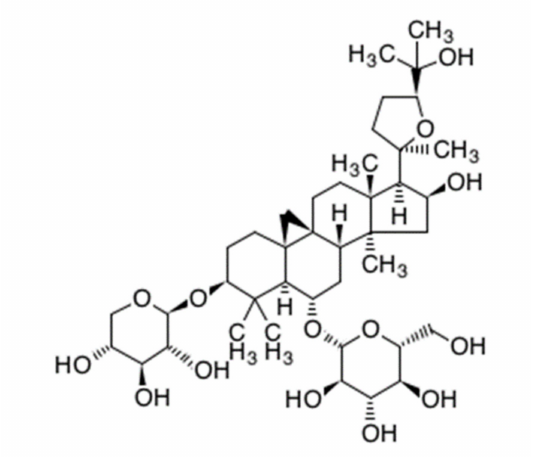
Figure 1. Chemical structure of astragaloside IV. (C 41 H 68 O 14 , molecular weight: 794.97 g/mol). The liver has ability to recover lost functional capacity after chemical or physical